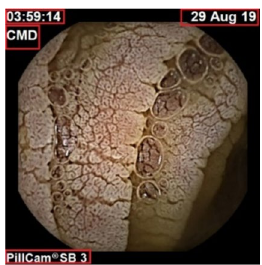
Figure 2. Unwanted